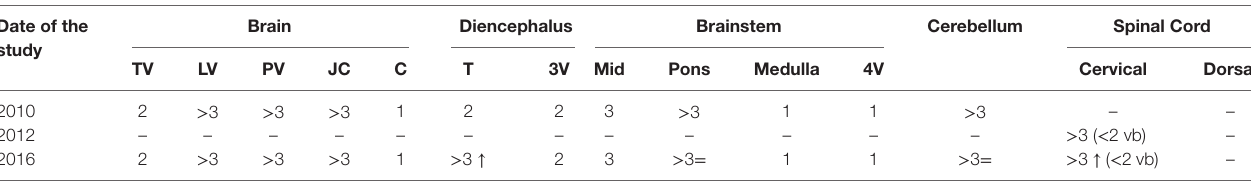
taBle 1 | Number of lesions in T2-weighted